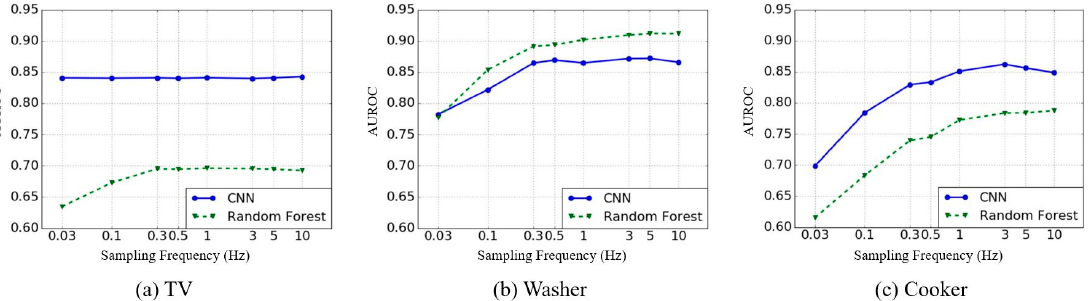
Figure 10. Sensitivity of classification algorithms to sampling rate. Sensitivities of CNN and Random Forest are shown where a larger value is desired for AUROC.